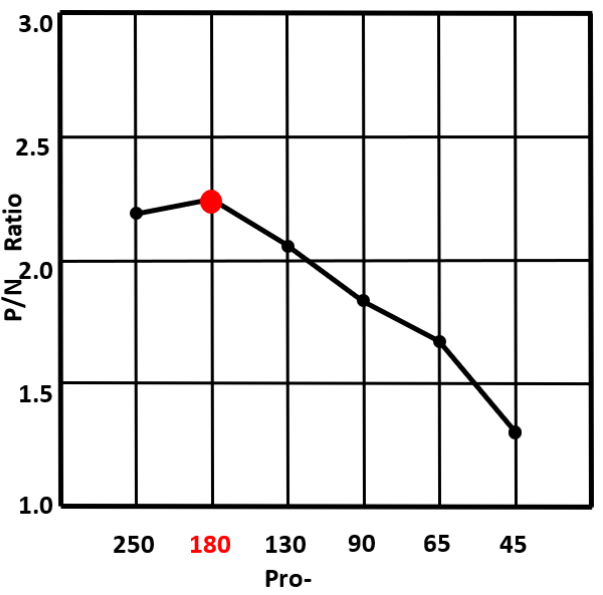
Figure 3. Width–length ratio of PMOS and NMOS under different process Figure 3. Width – length ratio of PMOS and NMOS under different process conditions.